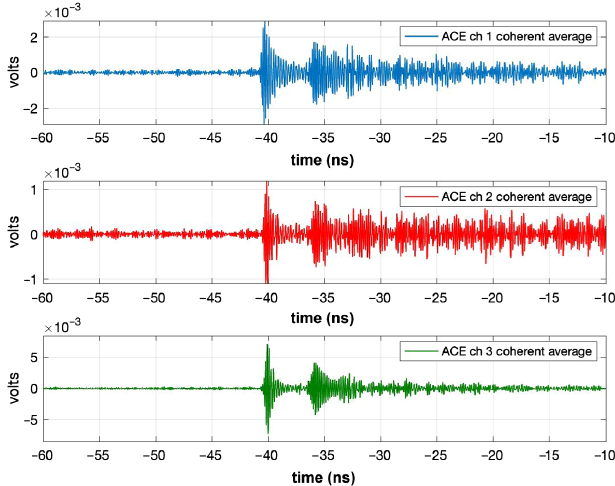
FIG. 8. Coherent average of runs 268 – 292 (2400 ACE events), showing all three ACE waveform responses, including the reflection from the shorted end about 4 ns after the initial pulse, to showers generated by electron bunches with parameters similar to those shown in Figs. 6 and 7. The first two elements (in blue and red) had lower efficiency due to degradation in the coupling at liquid helium temperatures. The third element (green) retained its full design efficiency and is used for all amplitude-dependent estimates of absolute